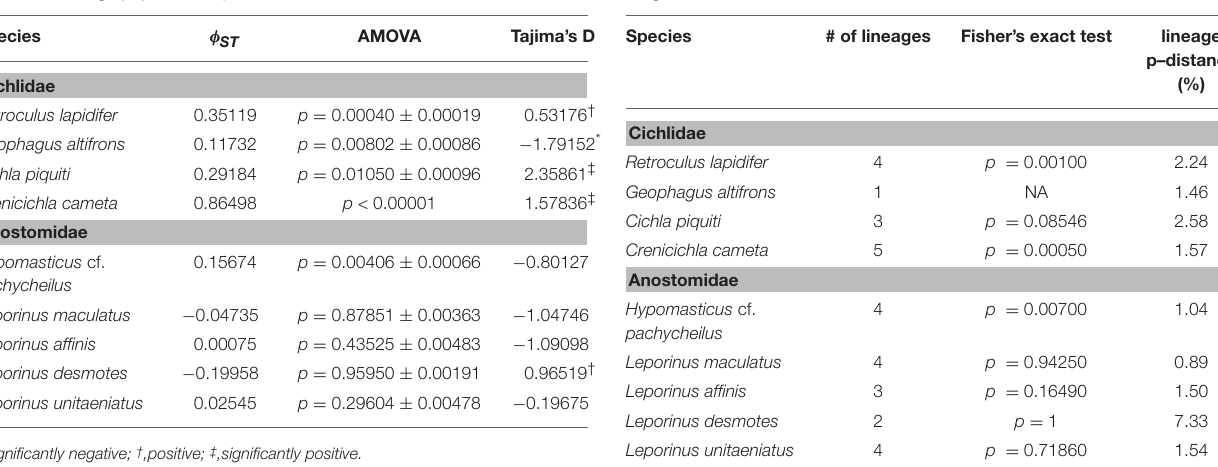
TABLE 4 | Analysis of non-random distribution of lineages among rapids of the Araguaia